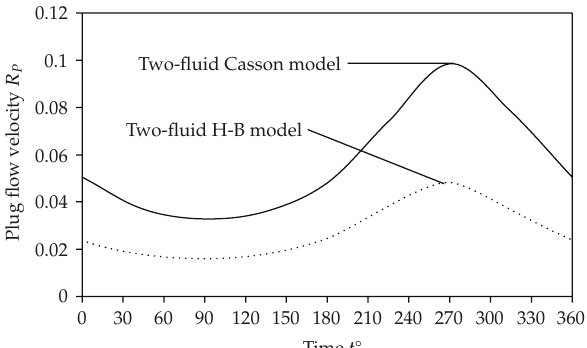
Figure 4: Variation of plug flow velocity in a time cycle of the two-fluid Casson and two fluid Herschel- Bulkley